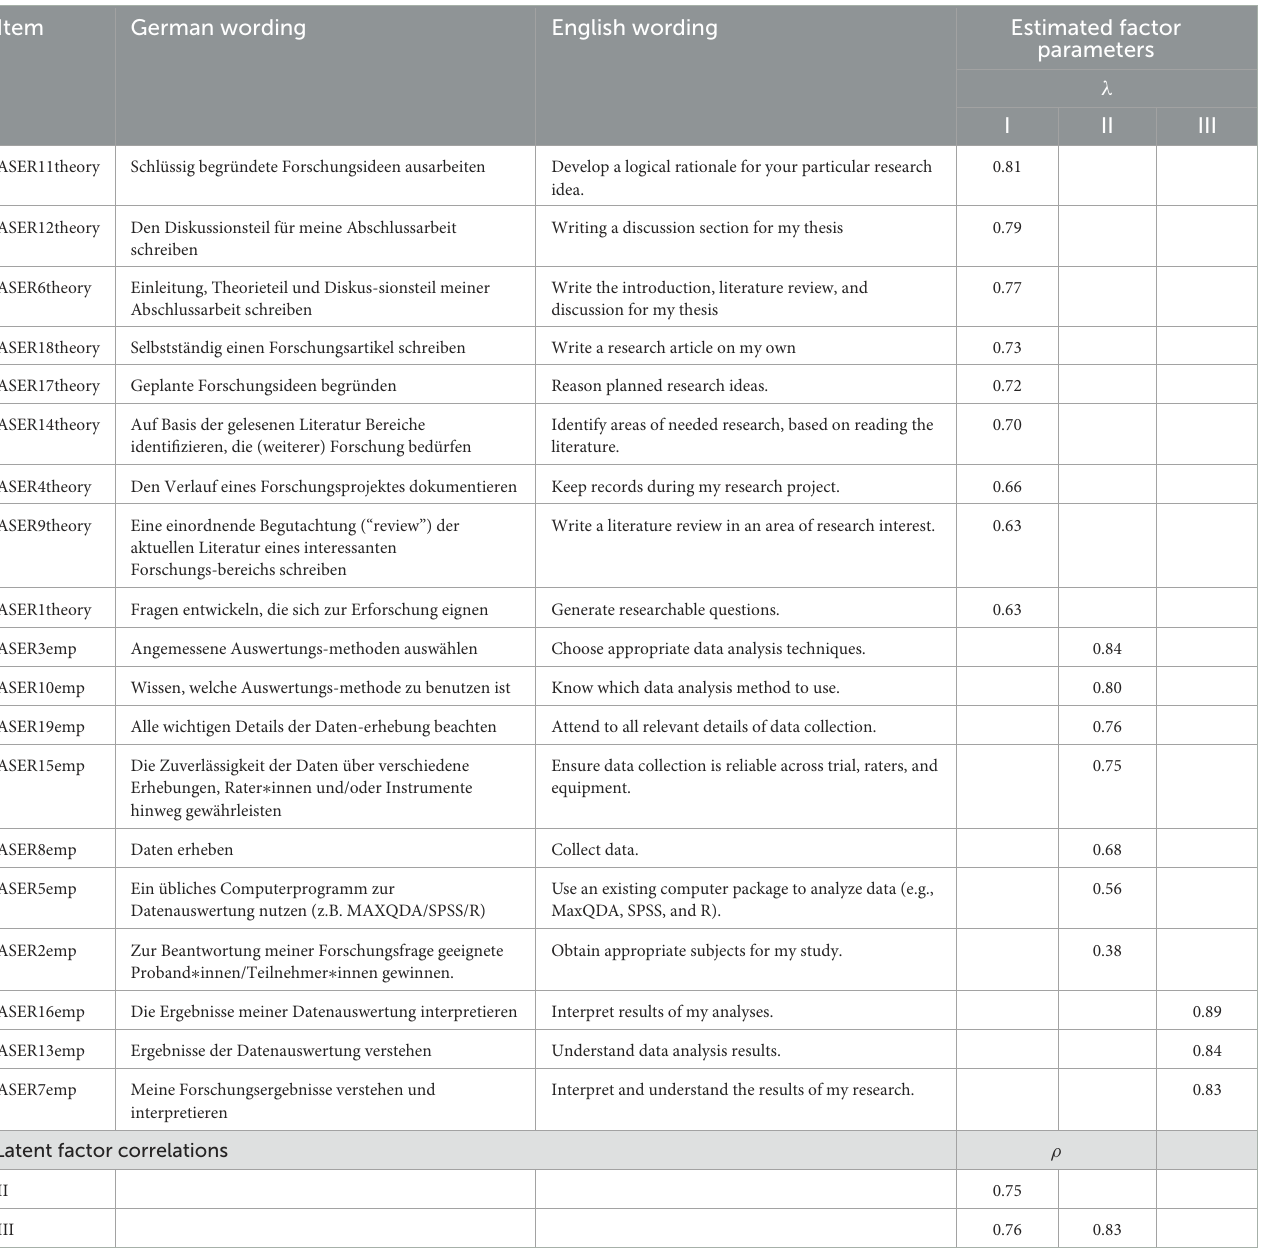
TABLE 1 ASER items and CFA parameter estimations of the three-factor ASER model.